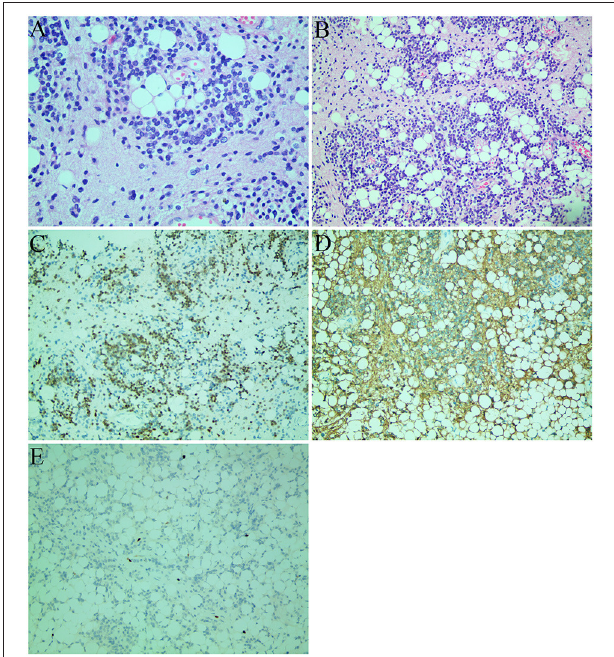
FIGURE 2 | Histological images (A,B) and immunohistochemical staining images (C–E) . (A) The tumor consisted of uniform round cells with small, round, or oval nuclei with finely speckled chromatin and large lipid vacuoles (hematoxylin and eosin staining; original magnification: × 400). (B) The tumor cells were accompanied by a large number of vascular hyperplasia and papillary structure. There were scattered adipose tissue and lymphatic structures in the tumor (hematoxylin and eosin staining; original magnification: × 200). (C) Strong NeuN immunopositivity of neoplastic cells. (D) GFAP-positive component and immunonegative neurocytic fields. (E) The Ki-67 proliferation index was